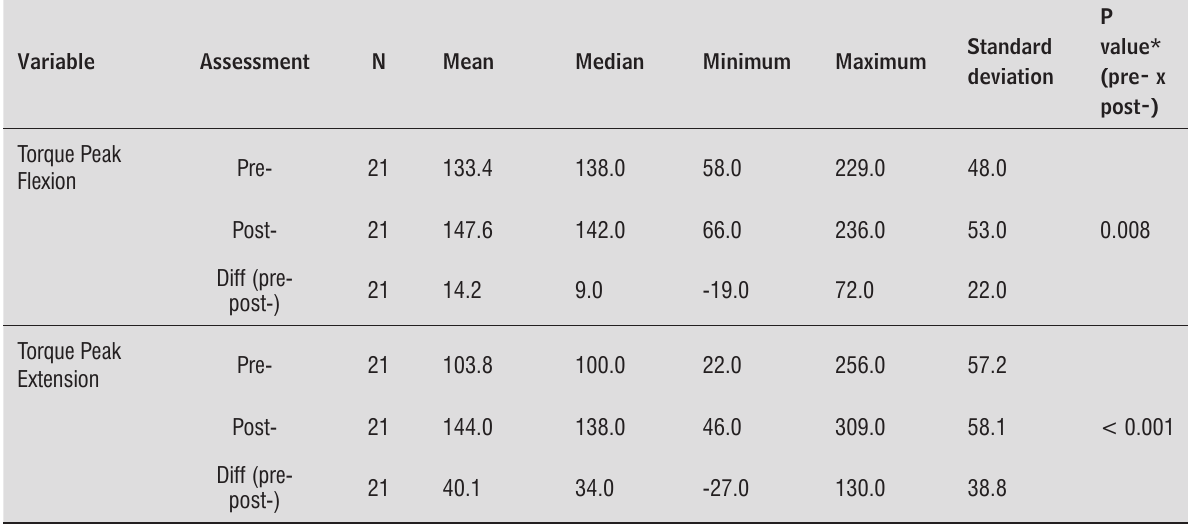
Table 3 - Descriptive statistics of the variables torque peak, work in flexion and extension, F/E ratio, and p values of statistical